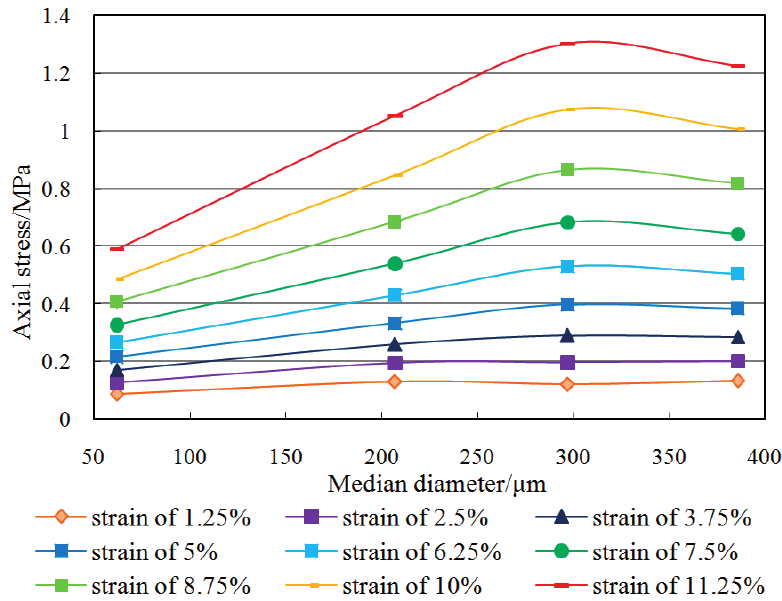
Figure 6. Axial stress versus median particle diameter under different strains.